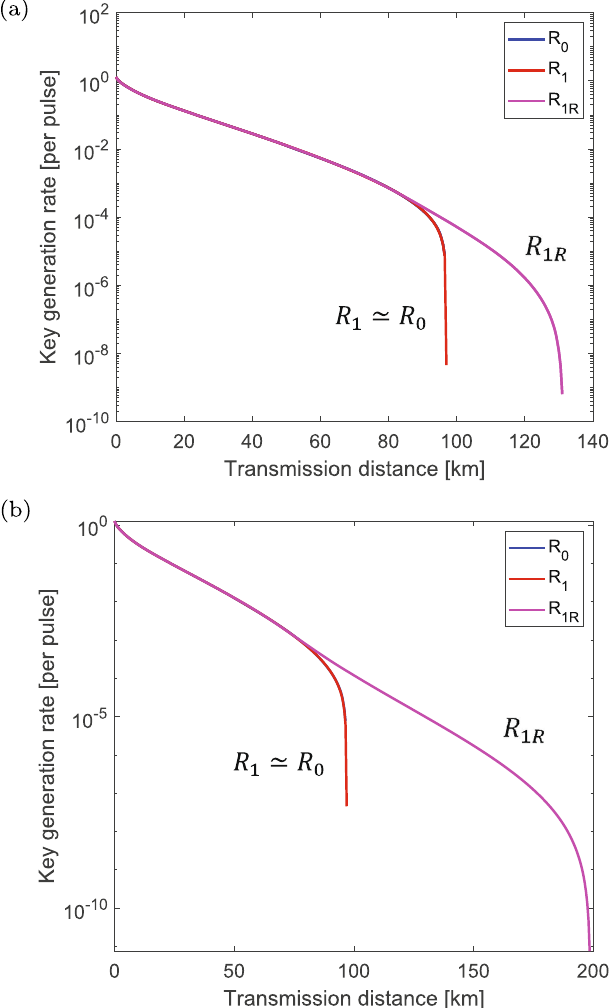
Fig. 2 The secret key rate of case (1) with uniform distribution. ( a ) Uniform distribution from 0.9 to 1.1 for R 1 ( b ) Uniform distribution from 0.8 to 1.2 for R 1 . Here, we compare the secret key rate, R 0 , R 1 , and R 1 R . In panel ( a ), the intensity fl uctuation model is a uniform distribution from 0.9 to 1.1. The secret key rate R 1 is approximately same as the key rate R 0 for ideal CV QKD system. In panel ( b ), the intensity fl uctuation model is a uniform distribution from 0.8 to 1.2.